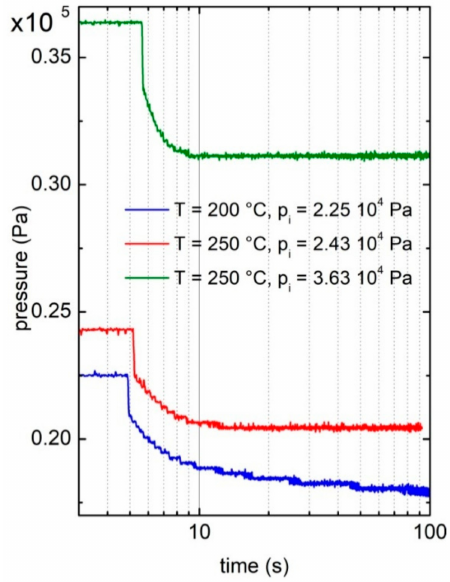
Figure 1. Hydrogen absorption kinetic curves at selected temperatures and pressures. In particular, the curves refer to the experimental condition reported in Table 1 as Test 11 (blue line), Test 13 (green line), and Test 14 (red